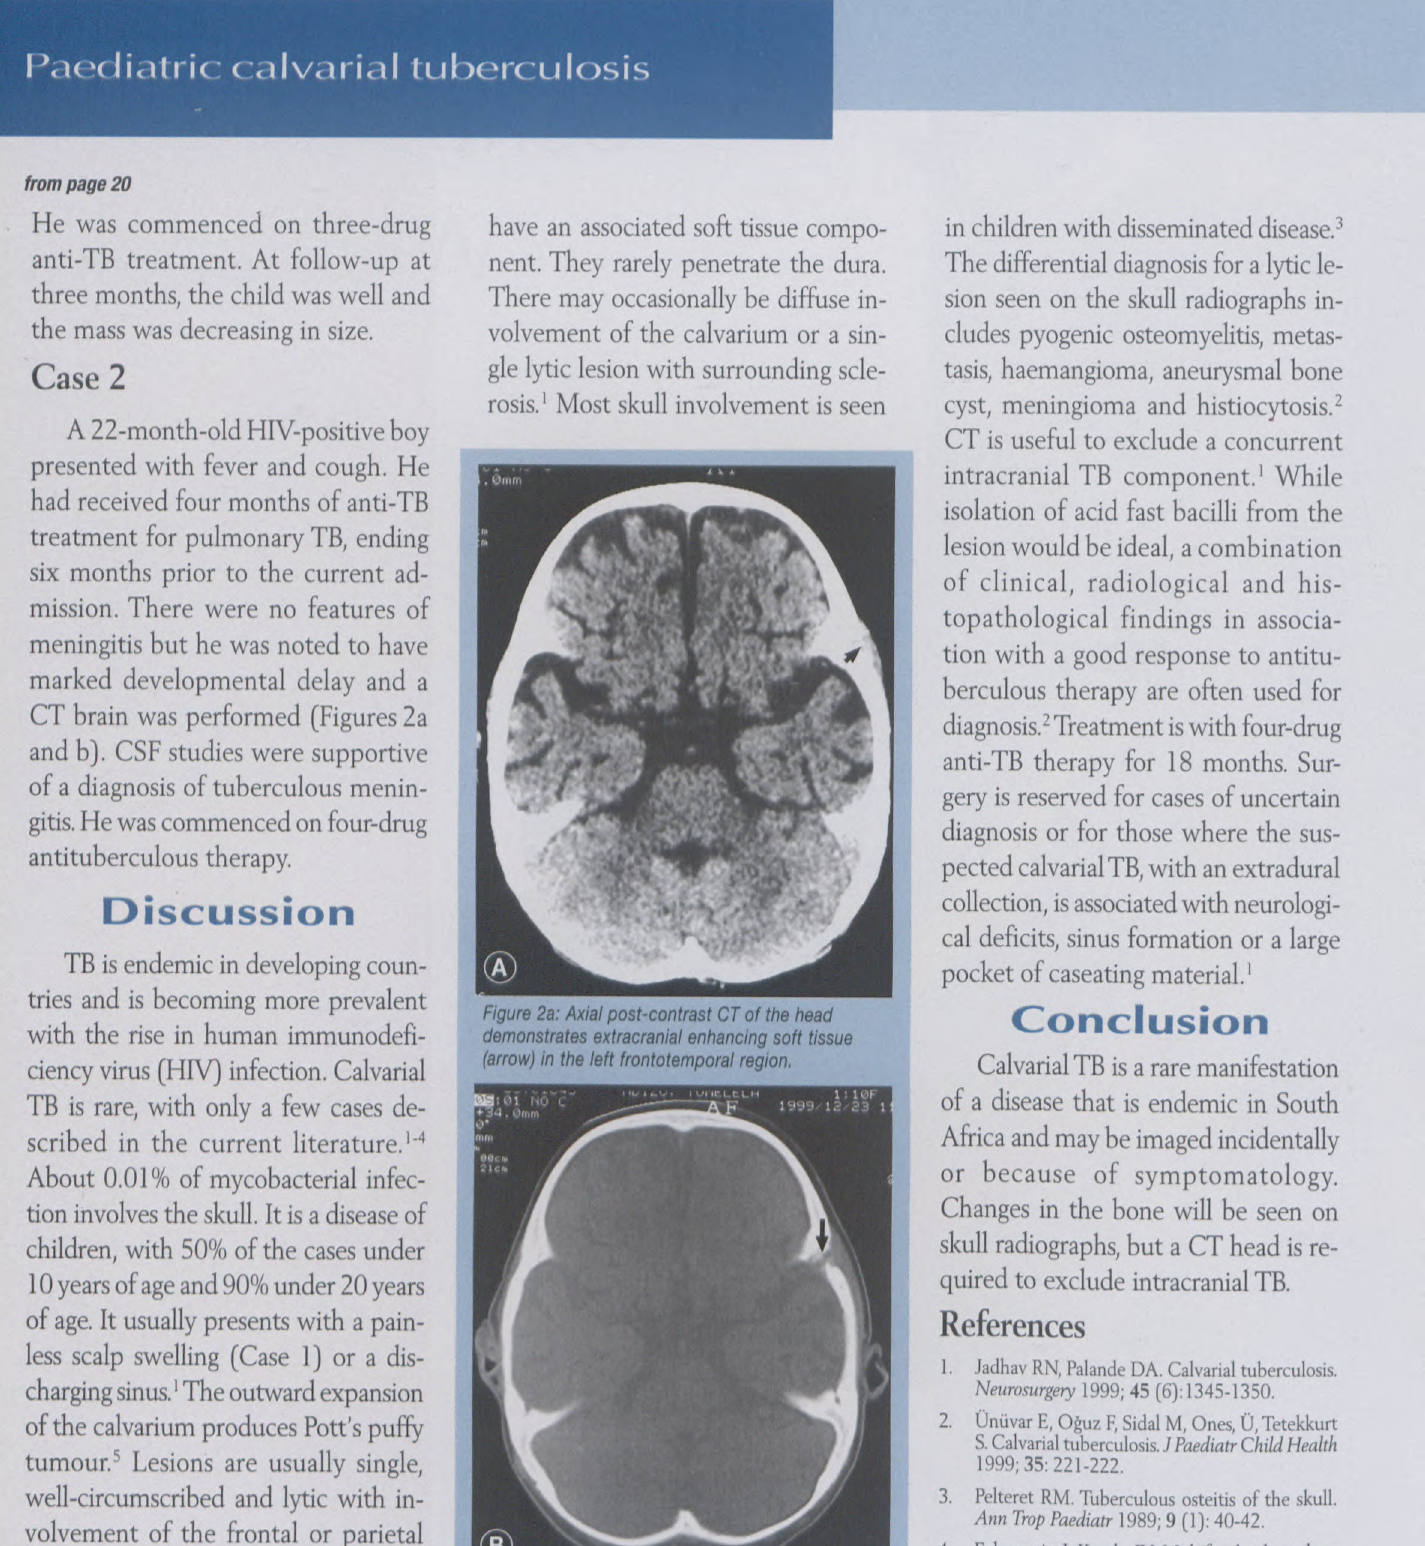
Figure 2b: Axial post-contrast CT of the head shows that the focus of the enhancing tissue seen in Figure 2a is associated with a lytic bone lesion